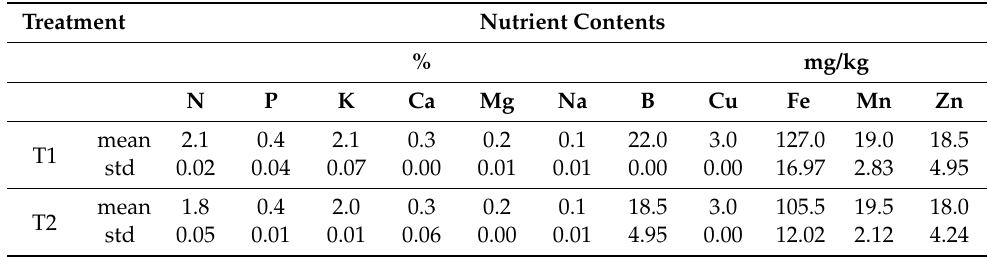
Table 4. Contents of minerals (macro and micro, in % and mg/kg of dry matter) in leaves and stems for both irrigating